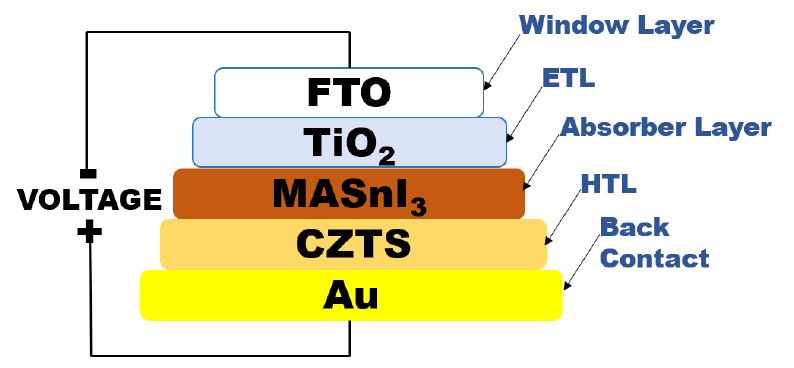
Figure 3. The n-i-p perovskite solar cell structure.